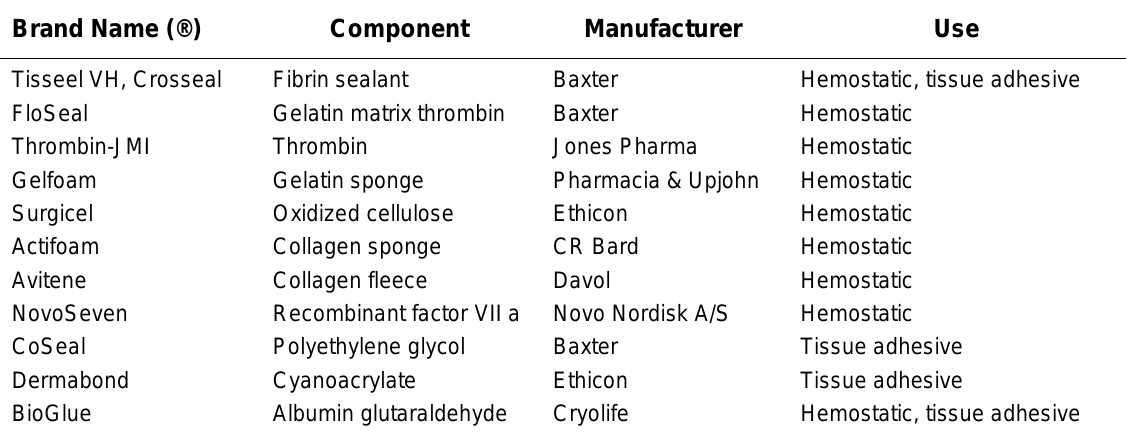
Hemostatic Agents and Tissue Adhesives Available in the